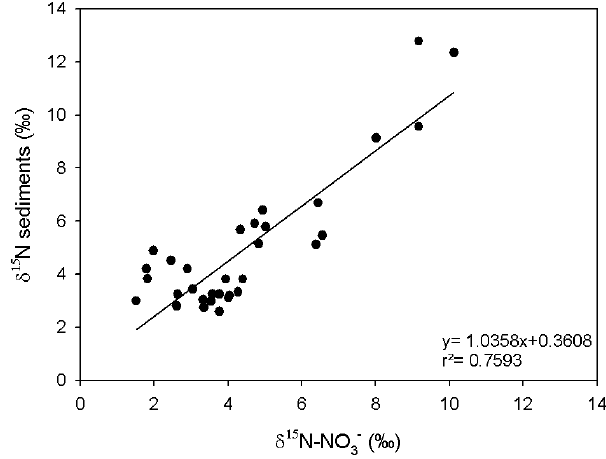
Figure 3. δ 15 N from sediment samples vs. δ 15 N- NO − face water samples. δ 15 N values from sediments were taken from Voss et al. (2005). The positive slope suggests a tight coupling be- tween δ 15 N- NO − in surface waters and δ 15 N in sediment samples. 3